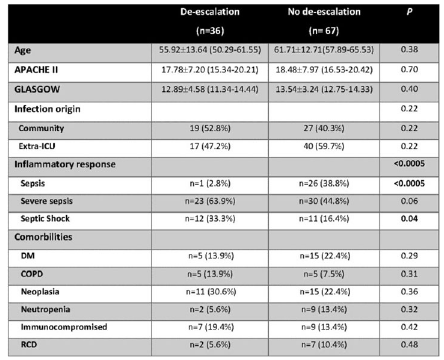
Table 1 (abstract 000935). See text for description